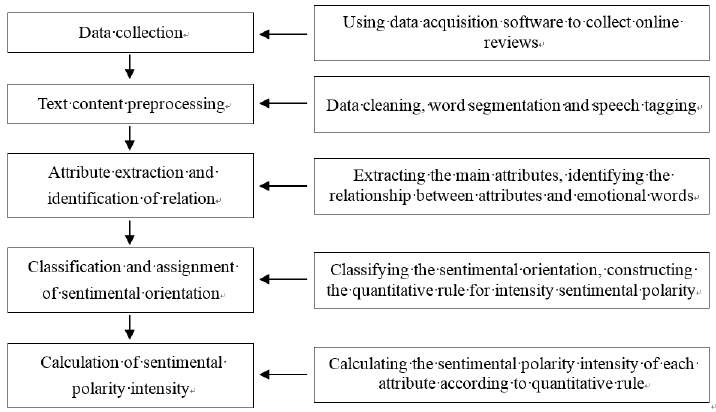
Fig. 1 The research process of sentiment